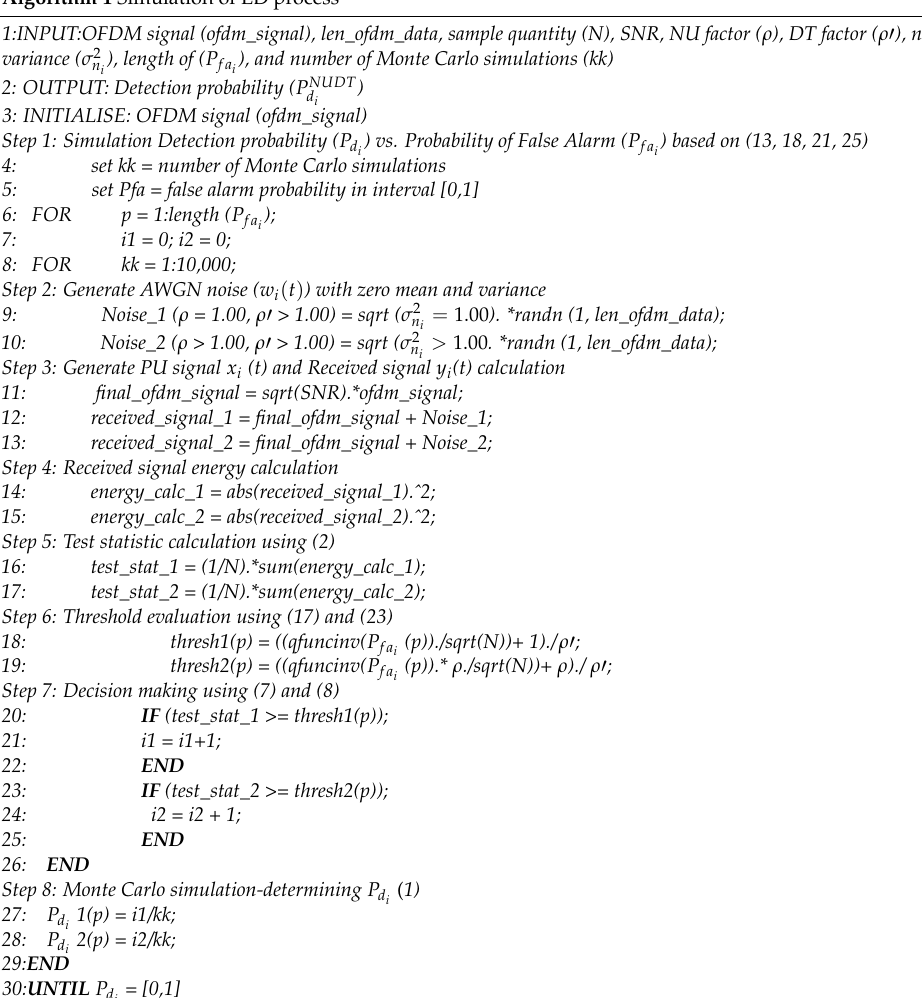
Algorithm 1 Simulation of ED